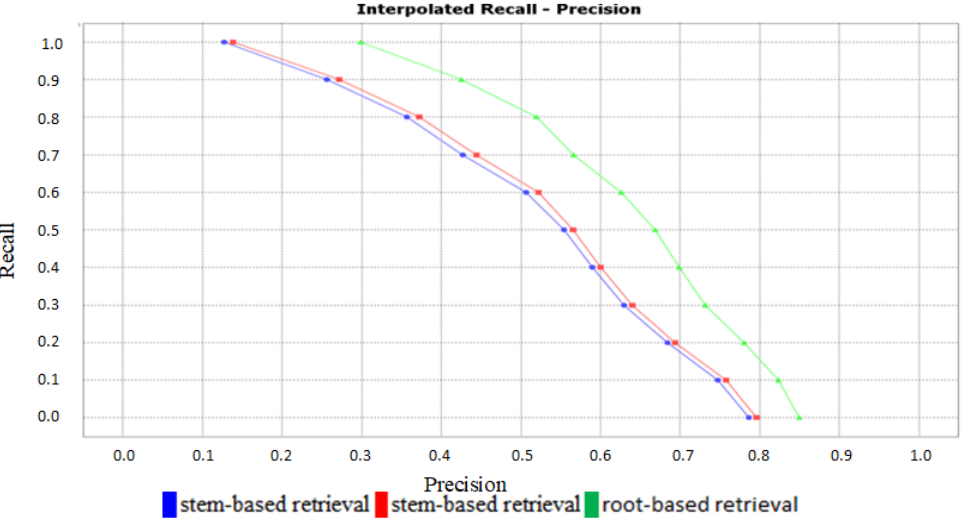
Figure 4. Recall-precision curves for the stem-based and root-based text representations.